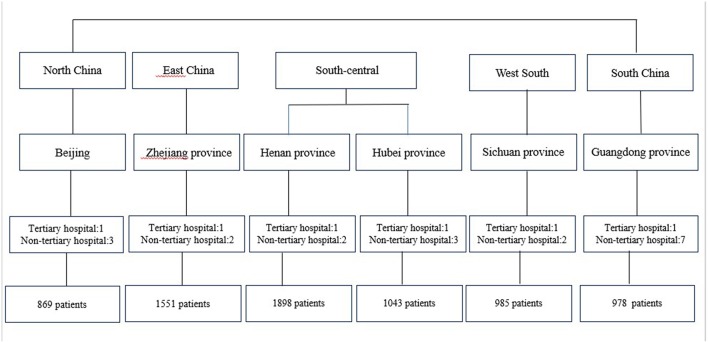
Sampling recruitment procedure.